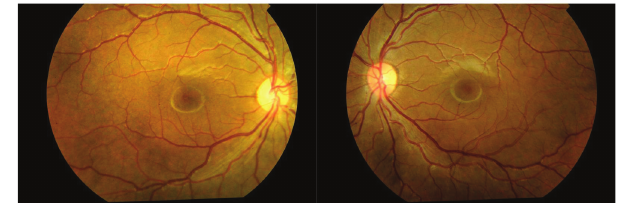
Figure 4. Fundus photograph at the three-week follow-up showing normal optic disc and